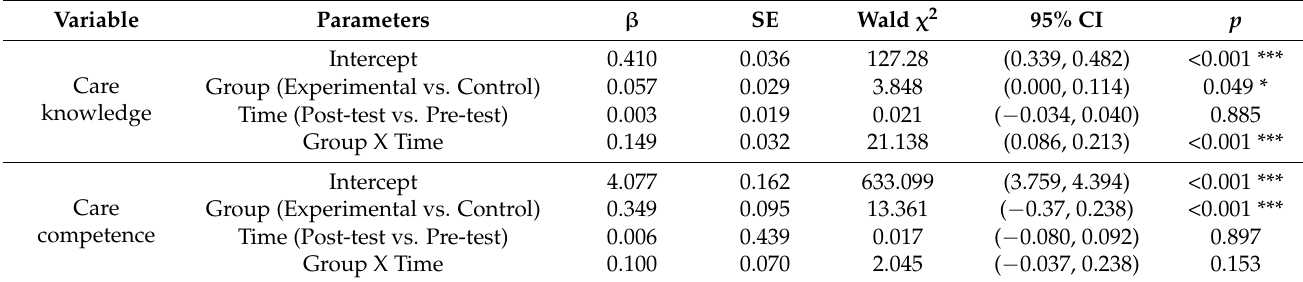
Table 4. Generalized estimating equation (GEE) analysis of care knowledge and care competence ( n = 85).